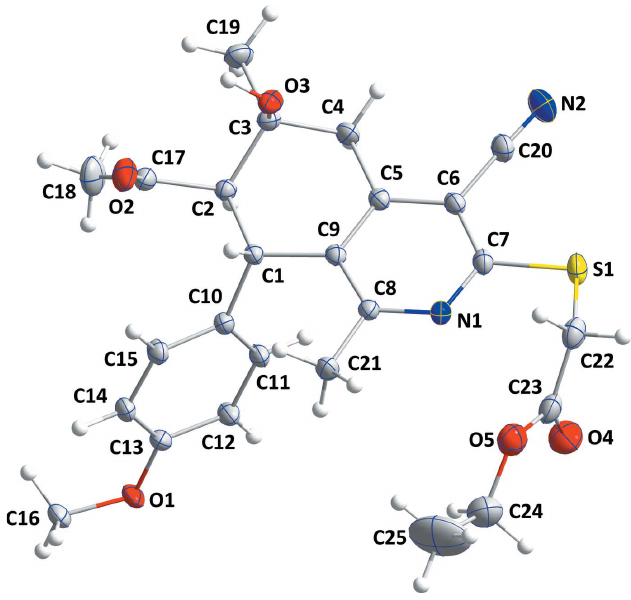
Figure 1 The title molecule with labelling scheme and 50% probability ellipsoids.